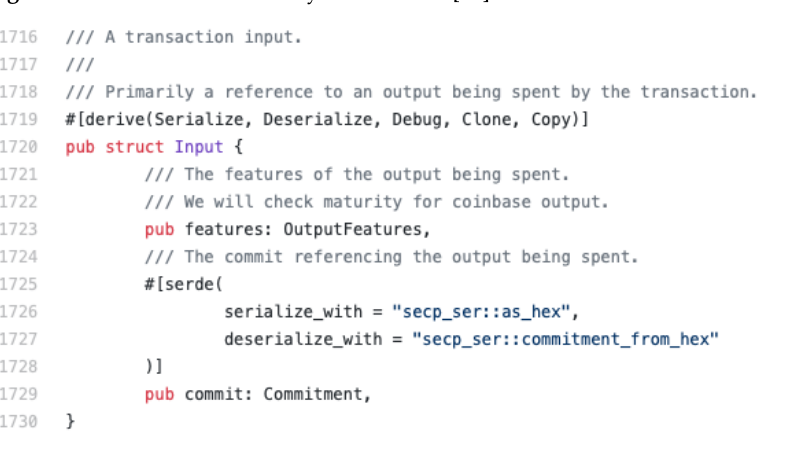
Figure A2. Grin input source code